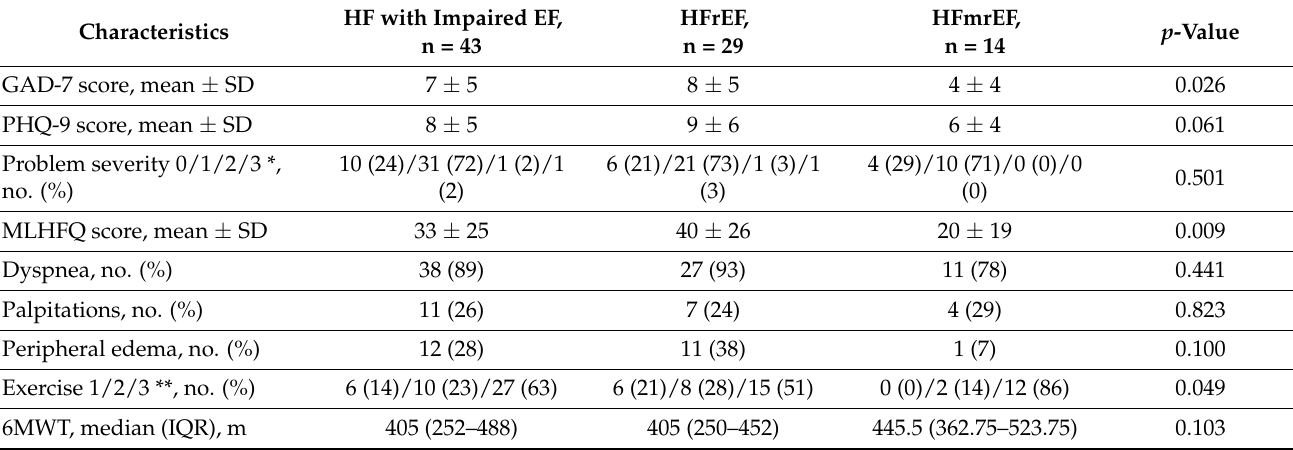
Table 2. Mental Health and HRQL in HF patients.